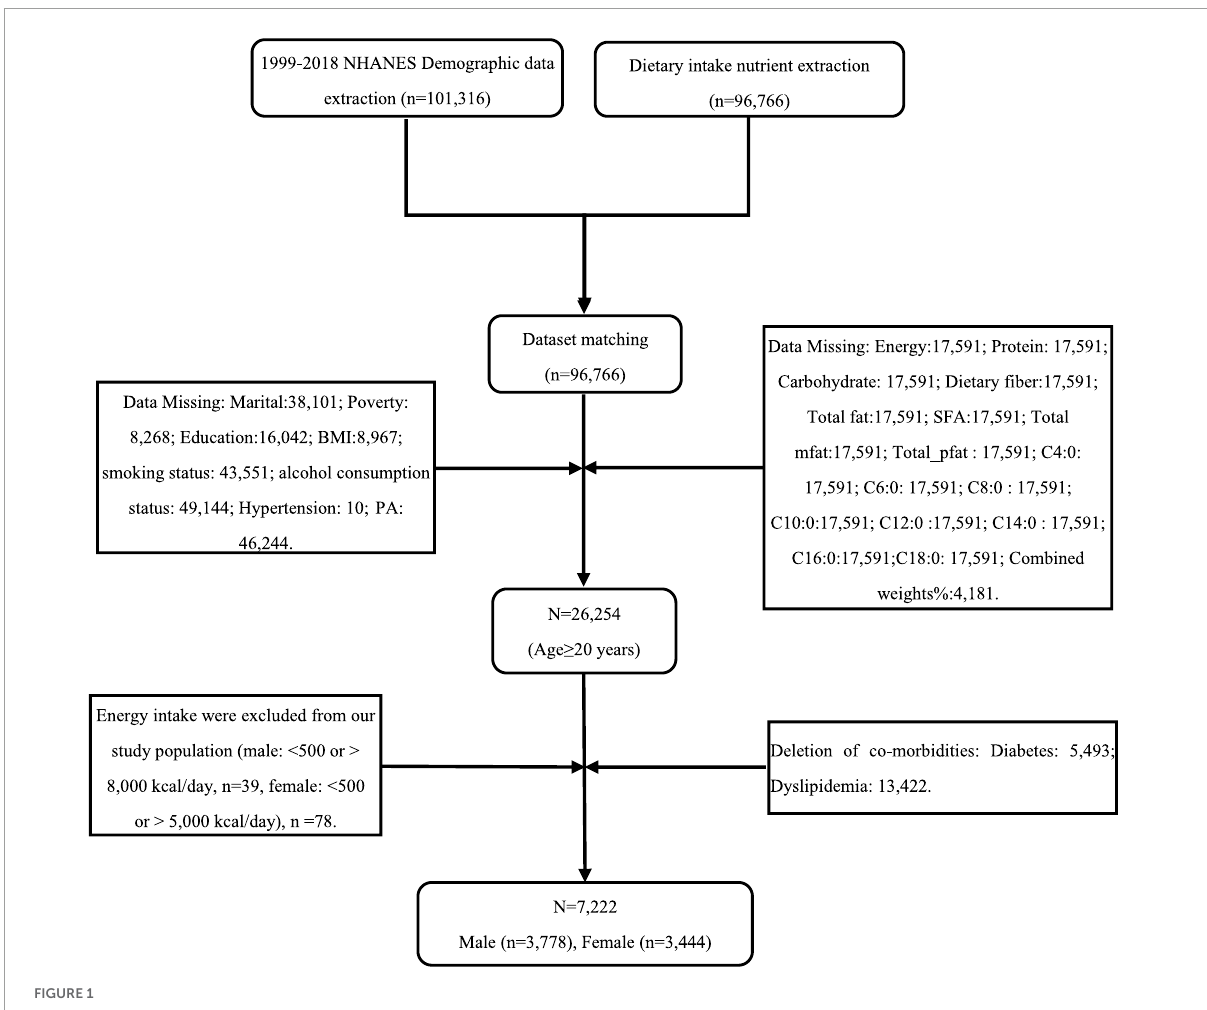
FIGURE1 Flow chart of the participants’